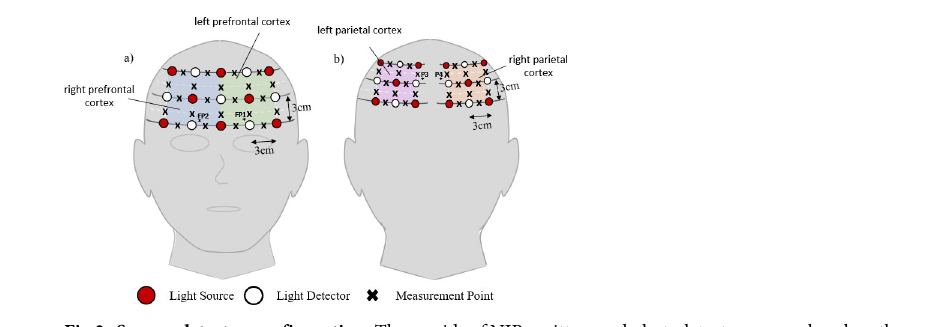
Fig 3. Source-detector configuration. Three grids of NIR emitters and photodetectors were placed on the participant’s head over the a) prefrontal and b) right and left parietal cortices. Each shaded circle (18) represents the location of an emitter in the configuration, and each unshaded circle (15) represents a photo detector. Each ‘x’ represents a measurement channel. Locations in the 10–20 International System are demarcated with an ‘ �